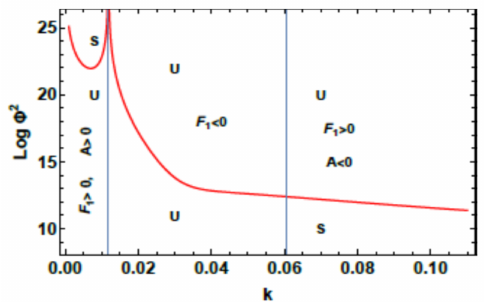
Figure 2. Plots of the stability bound for k versus Log Φ 2 .